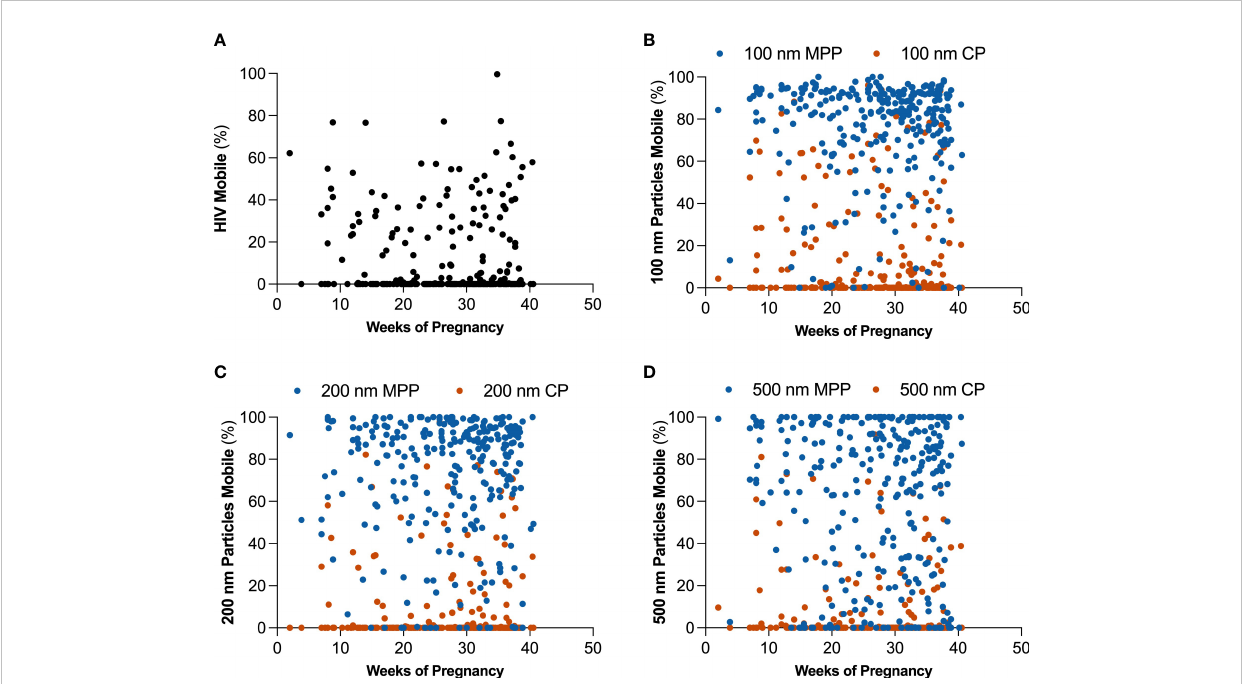
FIGURE 2 Changes in estimated percentage of mobile particles at t = 1 s over the course of pregnancy for (A) HIV virion, (B) 100 nm mucus penetrating particles (MPP) in blue and 100 nm conventional particles (CP) in orange, (C) 200 nm MPP in blue and 200 nm CP in orange, and (D) 500 nm MPP in blue and 500 nm CP in